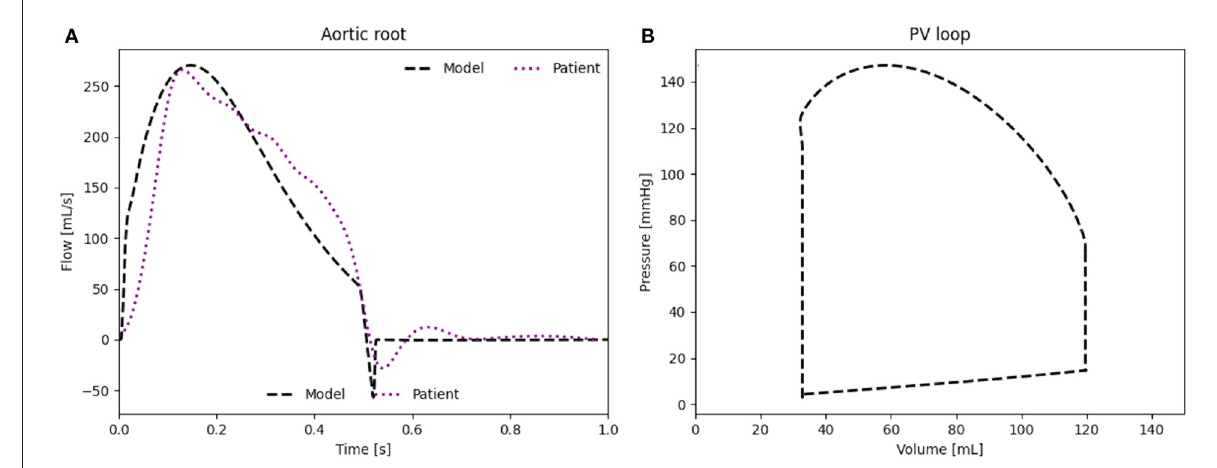
FIGURE4 (A) Flow rate through the aortic root induced by the LV. (B) PV loop of the LV of the patient-specific model.